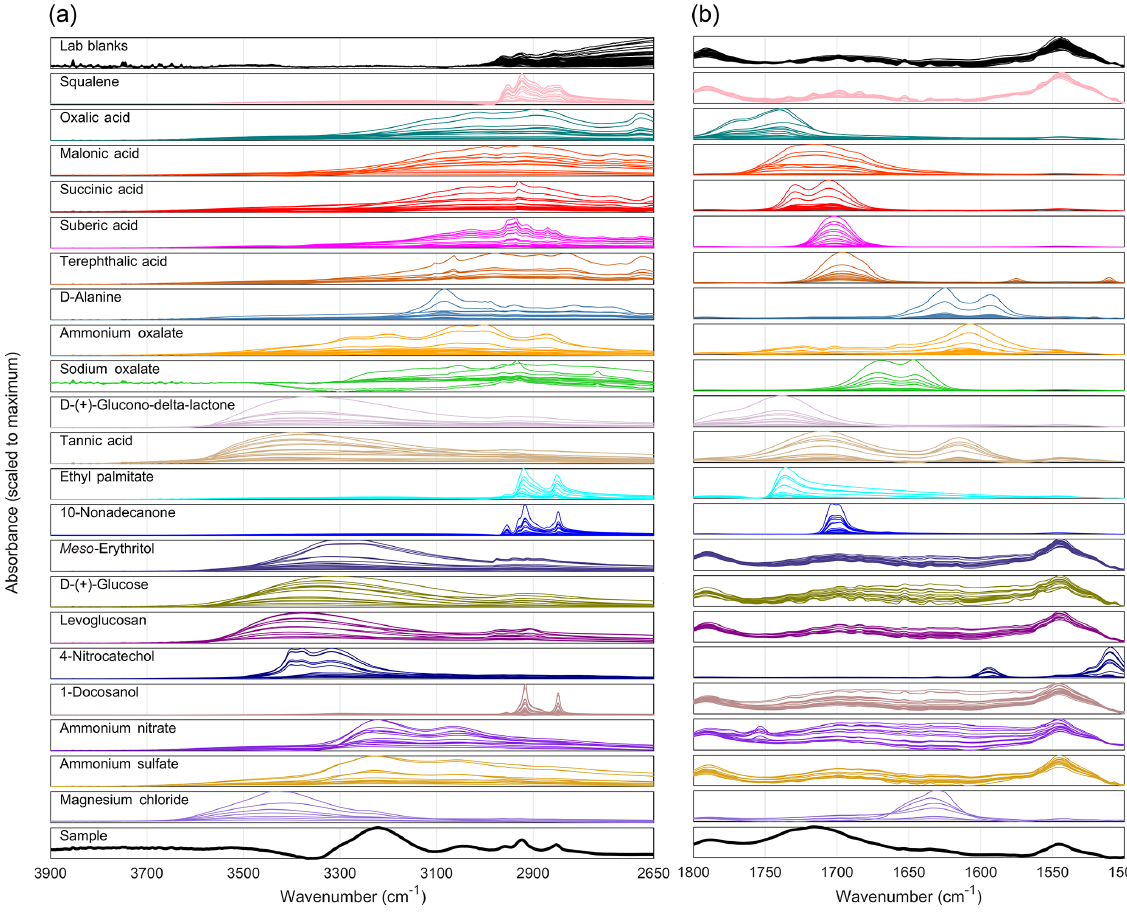
Figure 1. FT-IR spectra of all laboratory standards (calibration and test sets). The C-H, O-H, and N-H stretching region is plotted separately (a) from the C=O and C = C stretching region (b) . An example ambient SEARCH sample spectrum is plotted for comparison (bottom subplot; 13 October 2013 from Birmingham, AL). Spectra are baseline-corrected via smoothing splines (Kuzmiakova et al., 2016), and each subplot is scaled to the maximum absorbance for each wavenumber